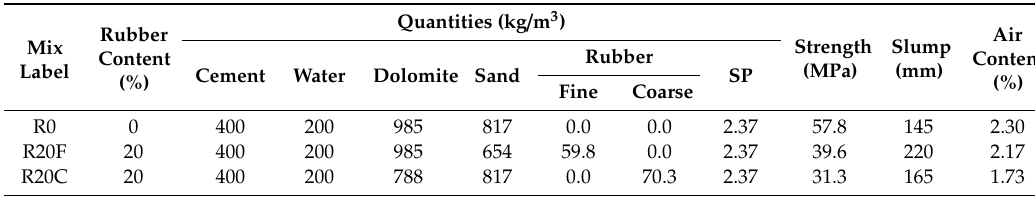
Table 1. Mix proportions and physical